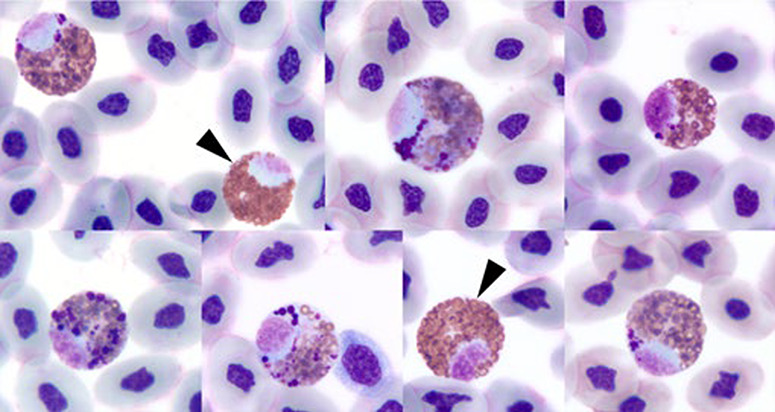
Heterophils of loggerhead sea turtle (C. caretta) hatchlings from Juno Beach showing representative images of immature heterophils with primary granules in comparison to two mature heterophils (arrowheads). ×100 objective, Wright–Giemsa stain.